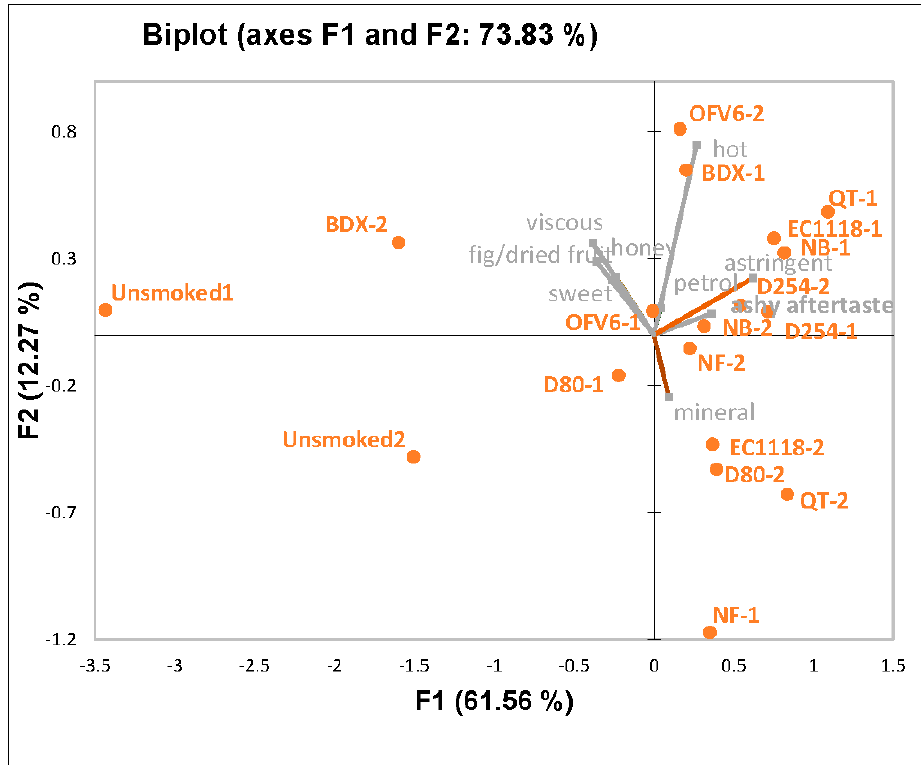
Molecules 2022 , 27 , x FOR PEER REVIEW Figure 1. PCA biplot of all wine treatments from panel 1. Figure 1. PCA biplot of all wine treatments from panel 1.